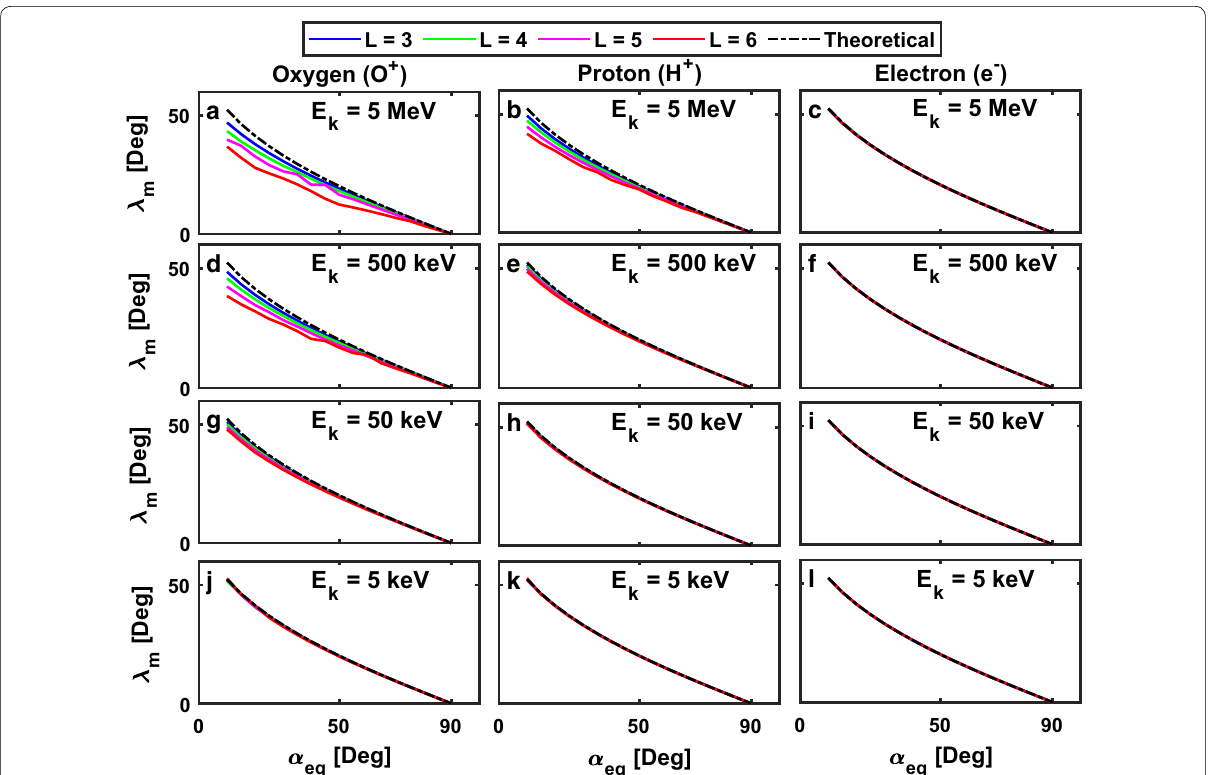
Fig. 4 The magnetic mirror point latitude as a function of equatorial pitch angle of the particle with different energy. a , d , g , j are for oxygen ions, b , e , h , k are for protons, and c , f , i , l are for electrons. The dashed black line is drawn from the theoretical Eq. (6) and solid lines correspond to the simulation results of (cid:31) m for fixed ψ = 90 ◦ , fixed energy and different L-shells ( L = 3,4,5,6